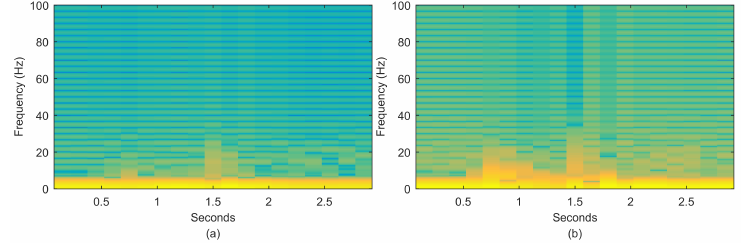
Figure 3. Energy distribution on frequency components: ( a ) walking; ( b )